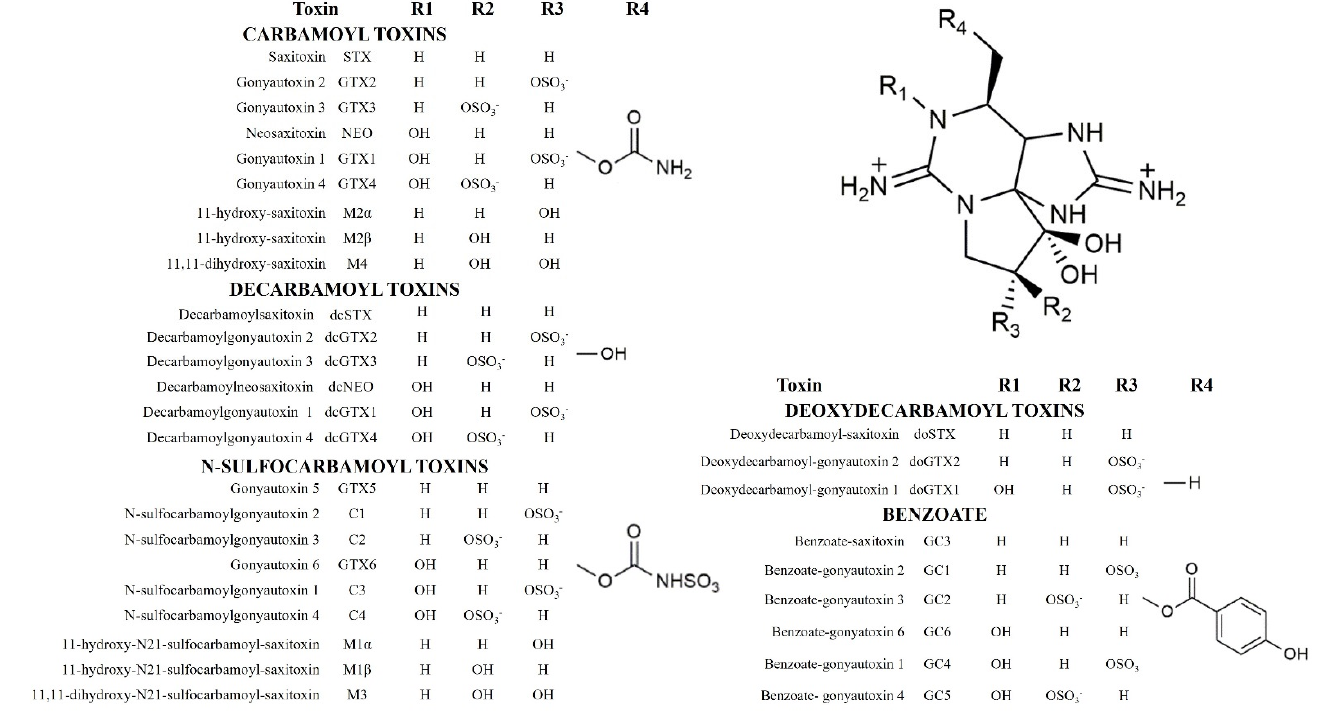
Figure 1. Chemical structures of the PST toxins identified and reported in literature. PSTs are produced by marine microalgae, specifically dinoflagellates of the genera.